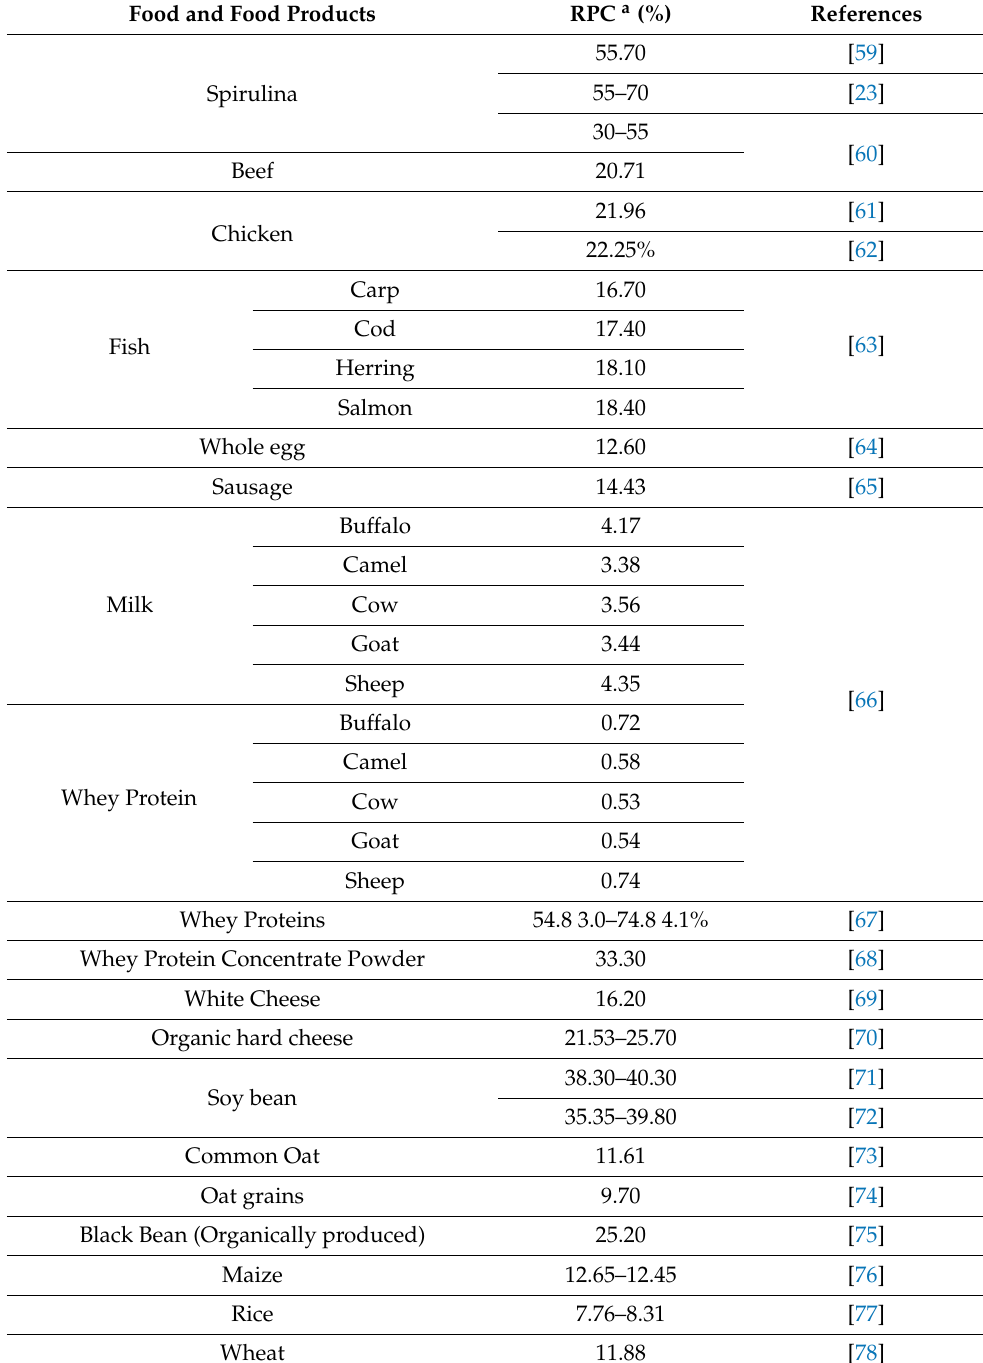
Table 2. A comparison of the relative protein content of spirulina algae with other food and food products based on the